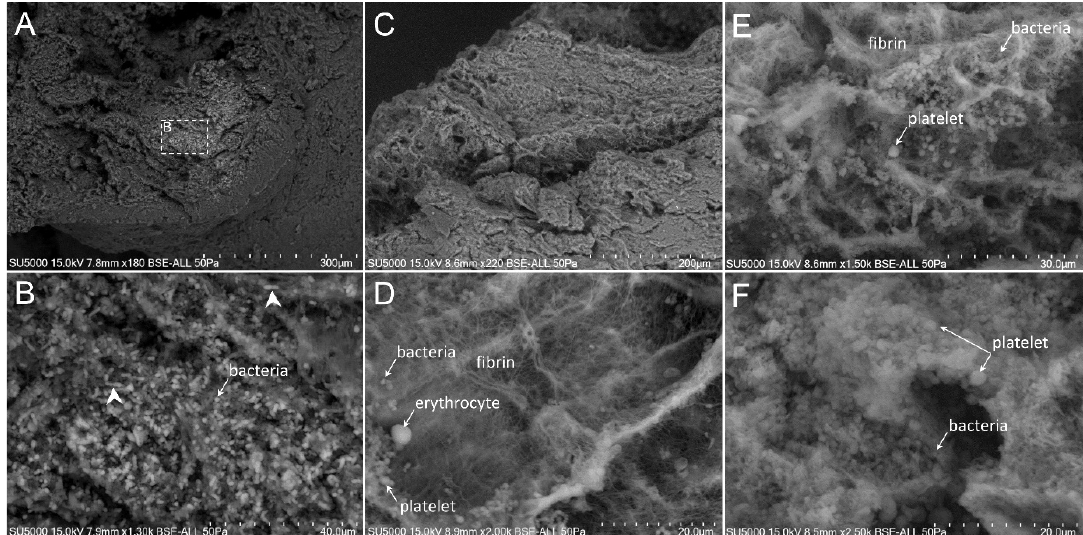
Figure 4. Scanning electron microscopy of S. oralis -infected vegetation. ( A ) Low magnification centered on a bright region of the vegetation. ( B ) Zoom-in on the boxed region in ( A ), showing numerous bacteria with typical proliferation features (arrowheads). ( C ) Low magnification of another region of the vegetation. ( D ) High magnification of the same region in ( C ) showing the fibrin network and its thin filaments or thicker bundles. ( E ) High magnification of platelets and bacteria mixed with fibrin. ( F ). Bacteria and platelet aggregates next to fibrin-rich regions.